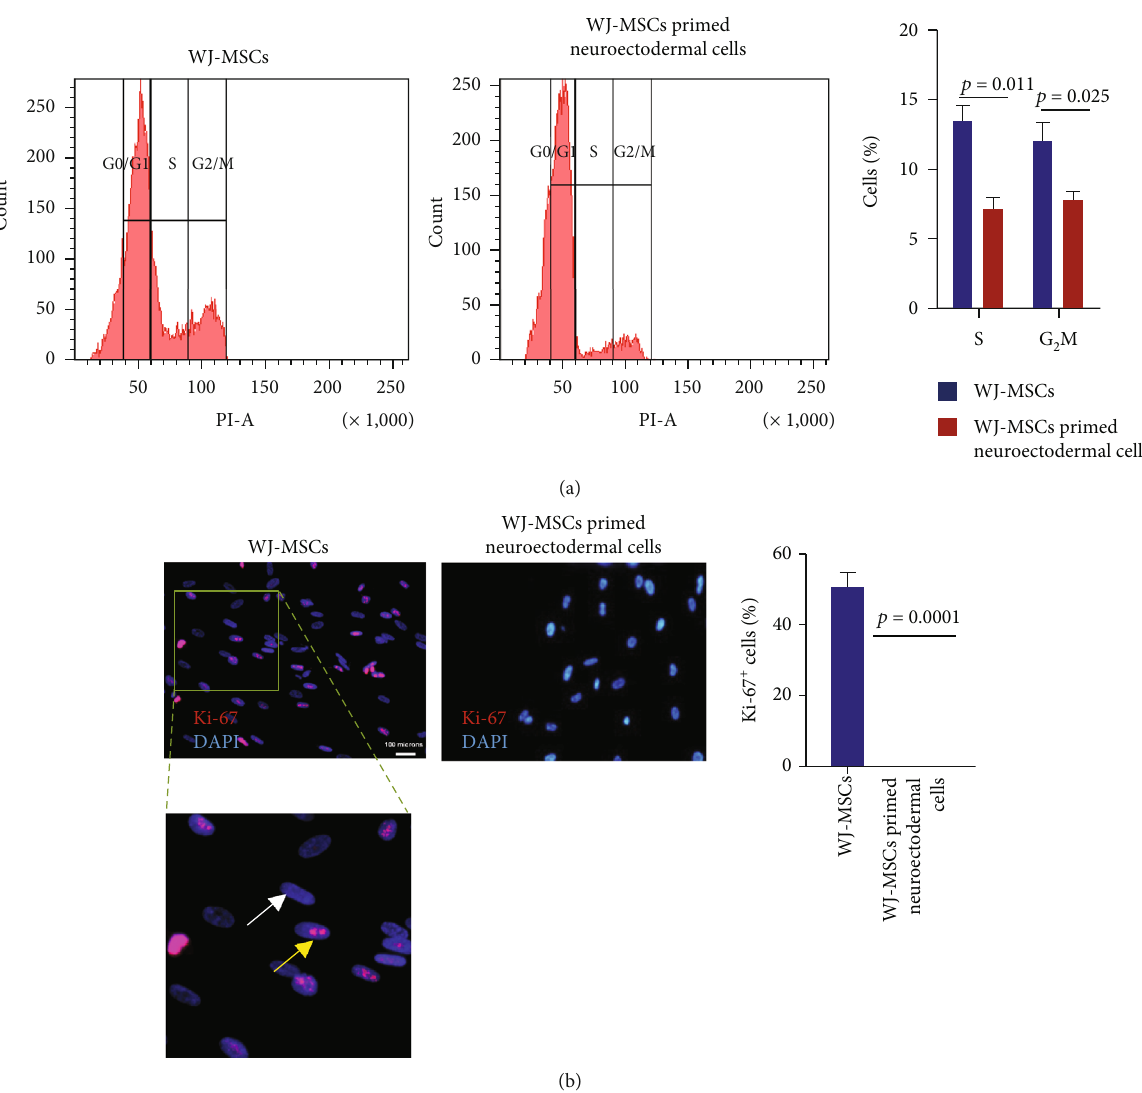
Figure 3: Proliferation status of WJ-MSCs and primed neuroectodermal cells. Panel A shows the representative fl ow cytometry pro fi le of Propidium iodide stained WJ-MSCs and the cells obtained after dissociating neuroectodermal spheres and their quantitative values are shown in the bar graph ( mean ± SEM , n = 3 ). Panel B shows the representative immuno fl uorescence image of Ki-67 stained WJ-MSCs and primed neuroectodermal cells and their quantitative values are shown in the bar graph ( mean ± SEM , n = 3